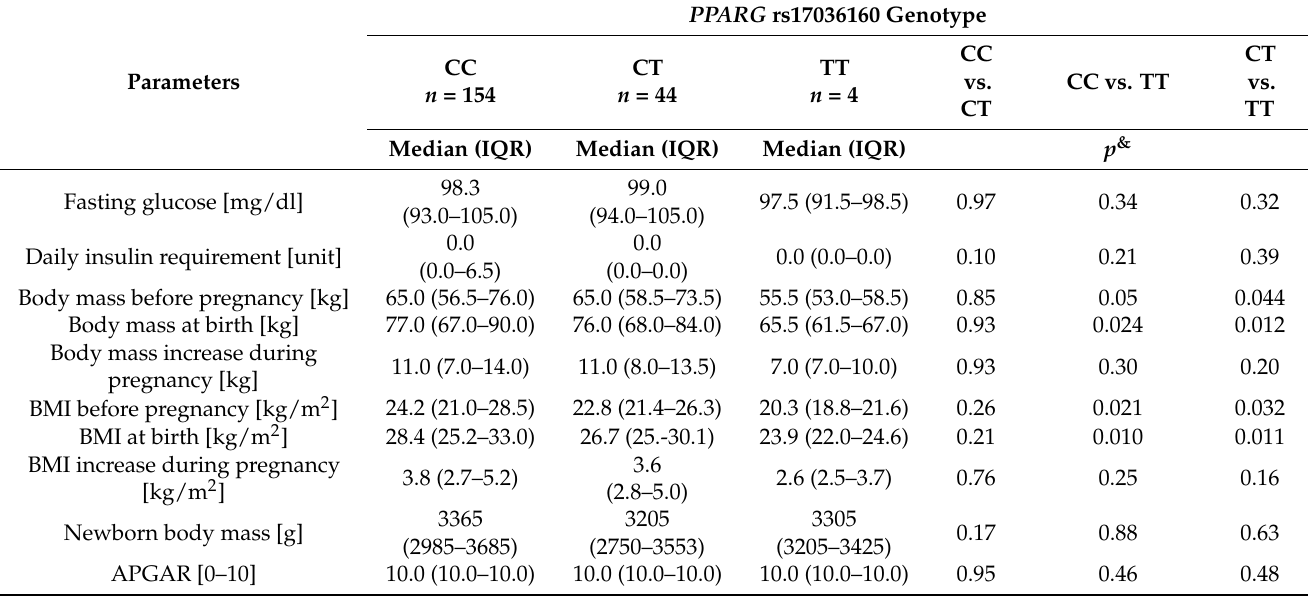
Table 2. Clinical parameters of women with GDM stratified according to PPARG rs17036160 genotype.